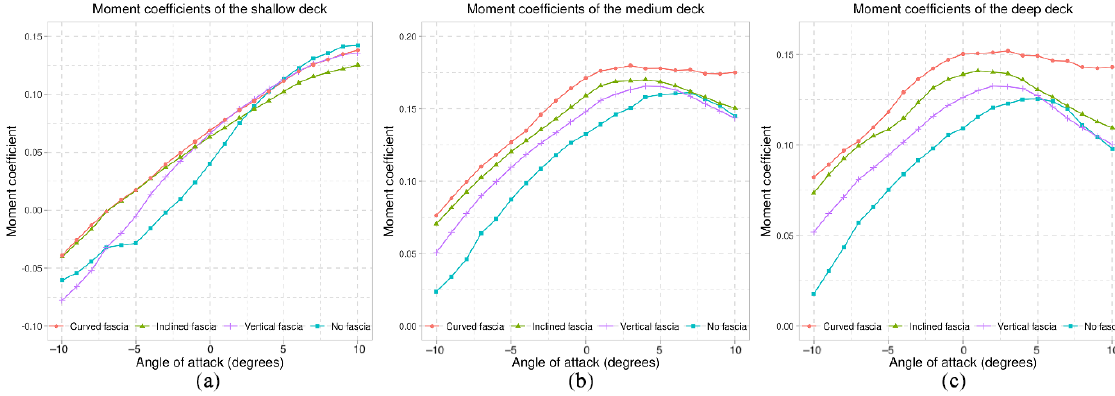
Figure 26. Change in moment coefficients for each fascia beam for the ( a ) shallow deck, ( b ) medium deck, and ( c ) deep deck.